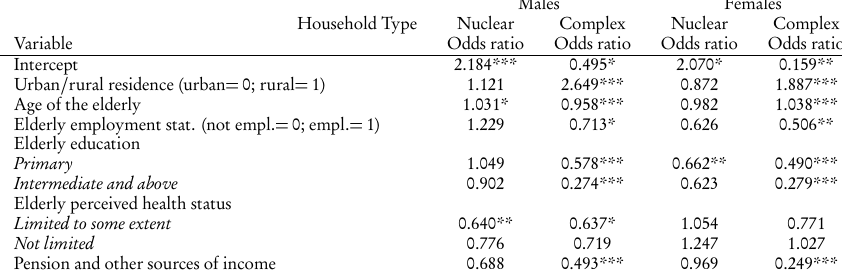
Estimation results. Notes: p-value significant to the *** 1% , ** 5% , and * 10%